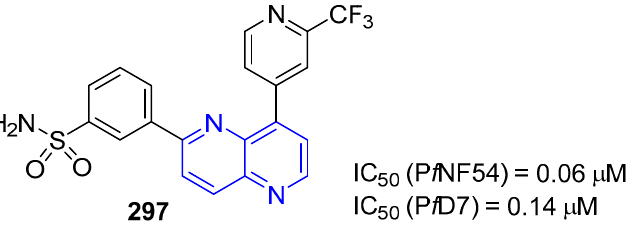
Figure 21. Evaluation of 1,5-naphthyridine-sulfonamides as antimalarial agents.